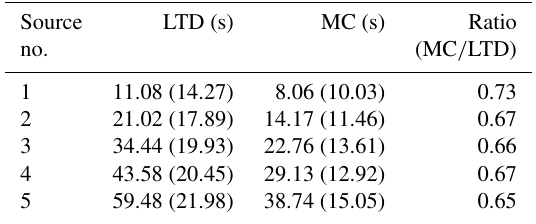
Table 4. Mean and standard derivation of the computation